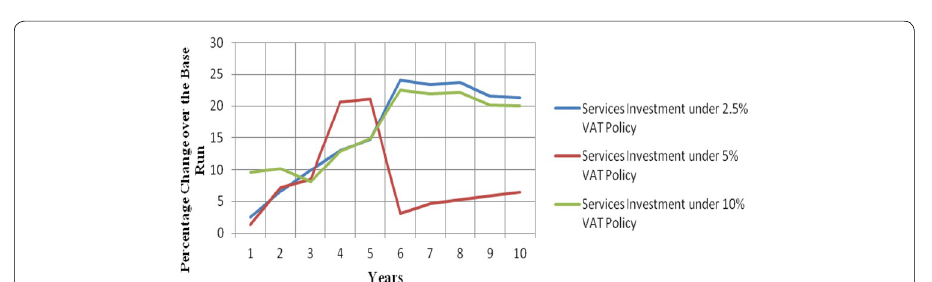
Fig. 26 Changes in services investment under varying VAT